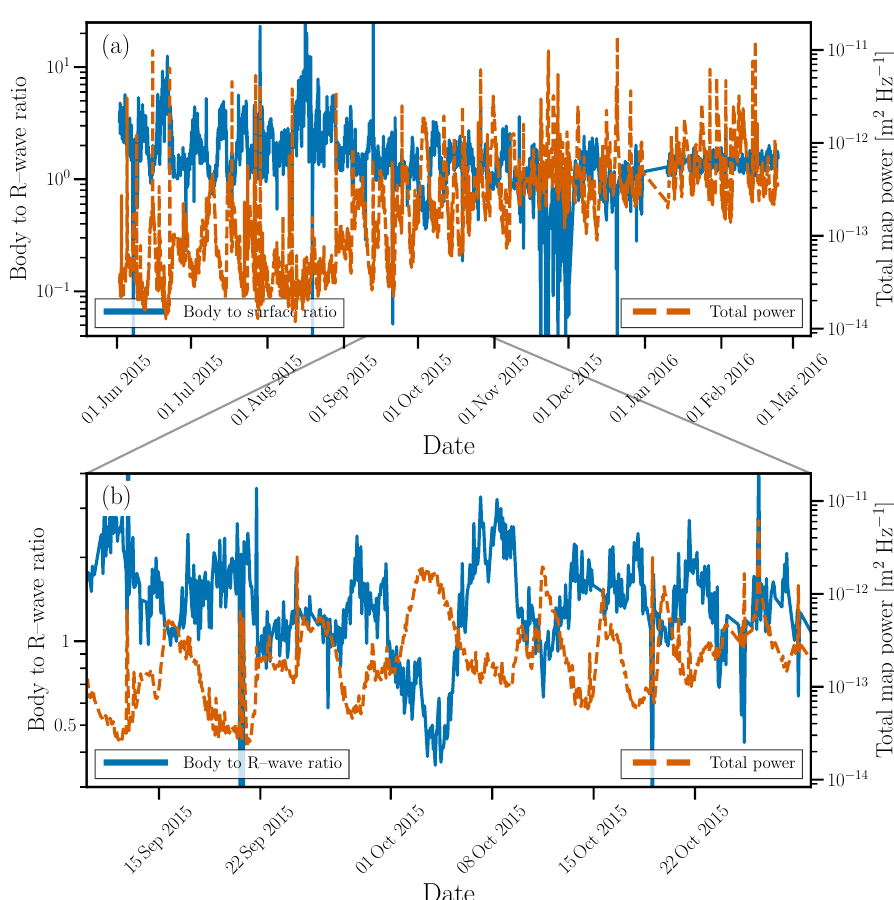
Figure 8. ( a ) Ratio of body-wave to R-wave power (blue solid) and total map power (orange, dashed). There is an obvious seasonal shift in total map power that corresponds to a decrease in the ratio of body waves to surface waves. In ( b ), we zoom in on fifty days. There is evident variability on a 7-day time-scale, and anti-correlation between total map power and the ratio of body waves to R ∼ waves. The variability is likely due to storms, which cause an increase in surface wave amplitude and hence an increase in total power and corresponding decrease in the ratio of body waves to R